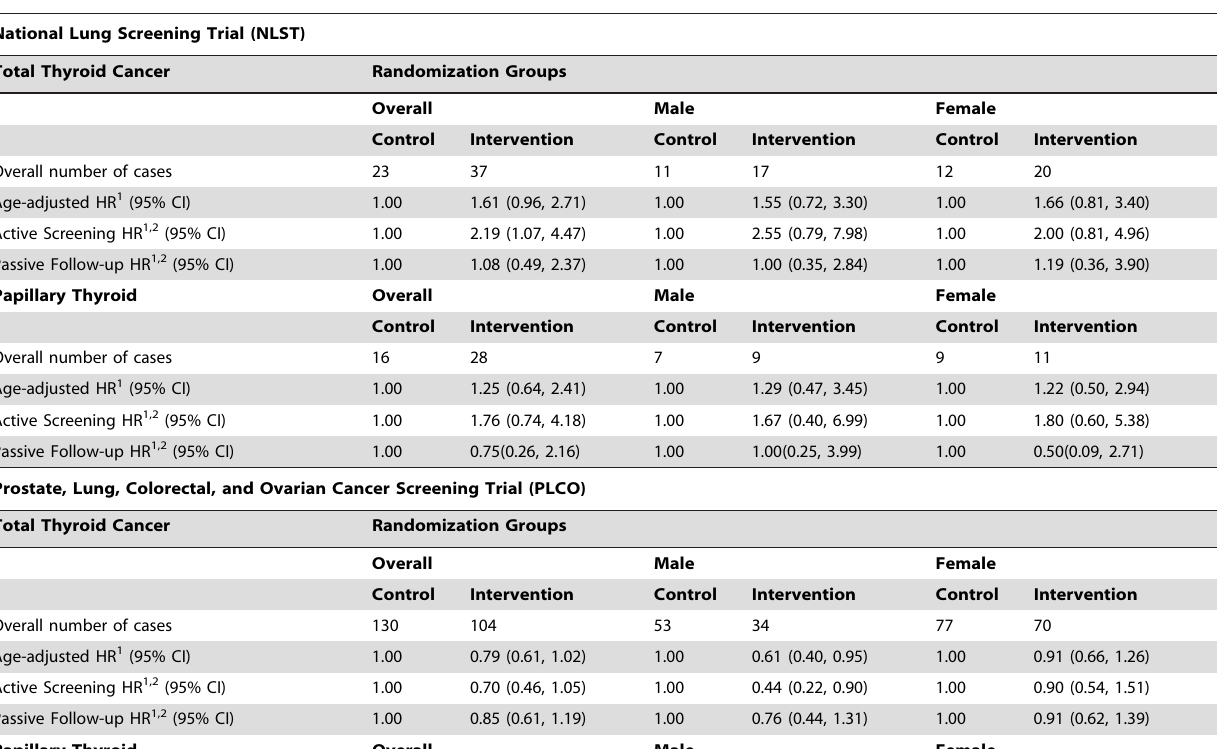
Table 3. Total Thyroid Cancer and Papillary Thyroid Cancer Risk in NLST and PLCO by randomization group.